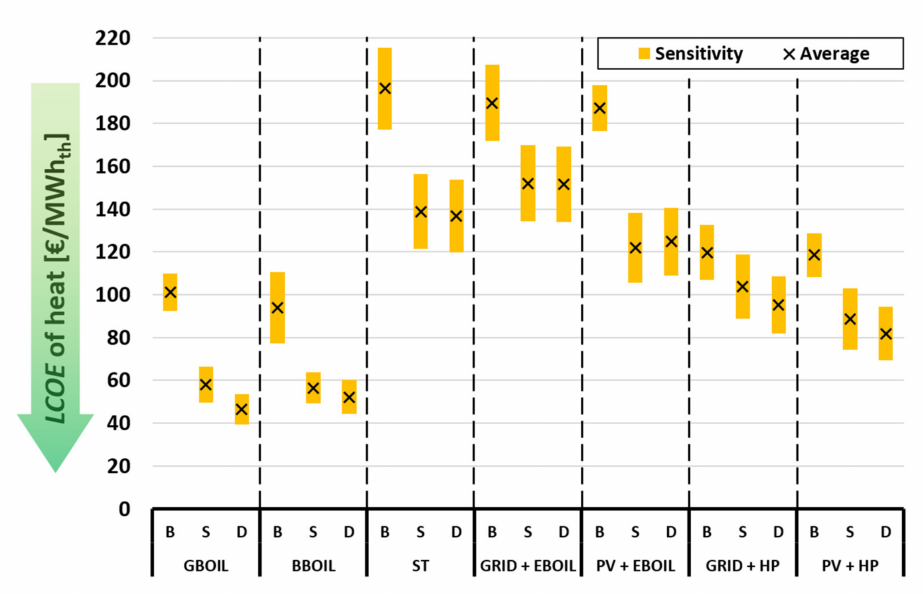
Figure 8. Sensitivity of LCOE to variations in investment and fuel costs.